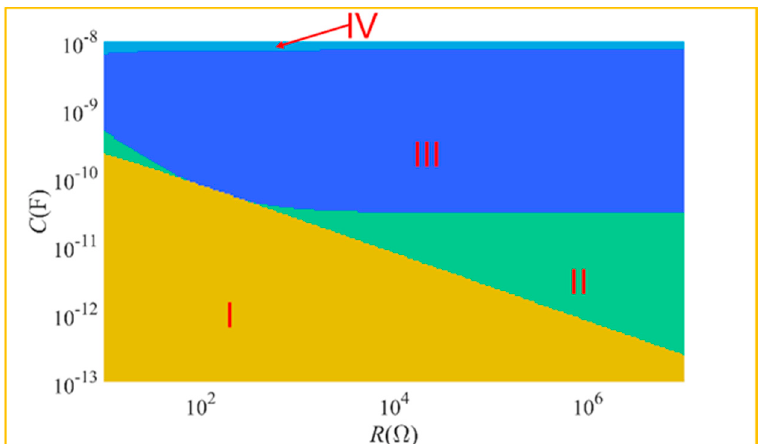
Figure 6. Input impedance characteristic diagram depending on R and C parameters. I—passive region; II—edge of chaos region; III—sharp edge of chaos region (dynamic); IV—sharp edge of chaos region (static).